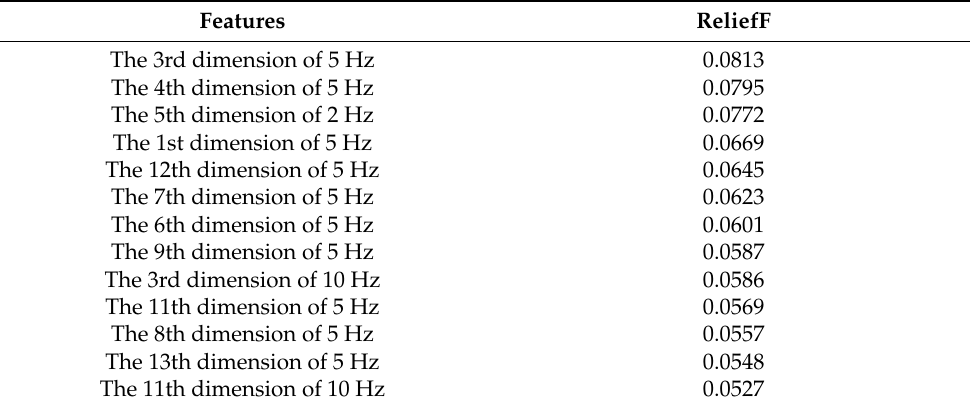
Table 2. First 13 dimensional features in four-category